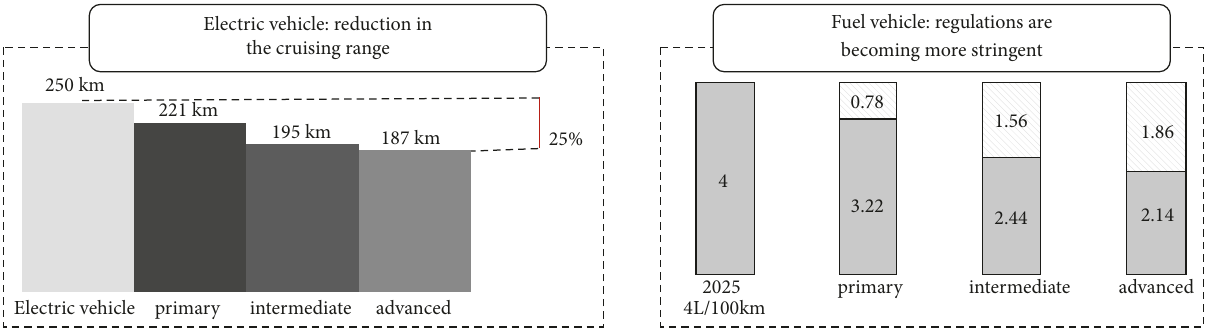
Figure 8: The impact of intelligent car on the fuel consumption of fuel vehicles and the cruising range of electric vehicles.